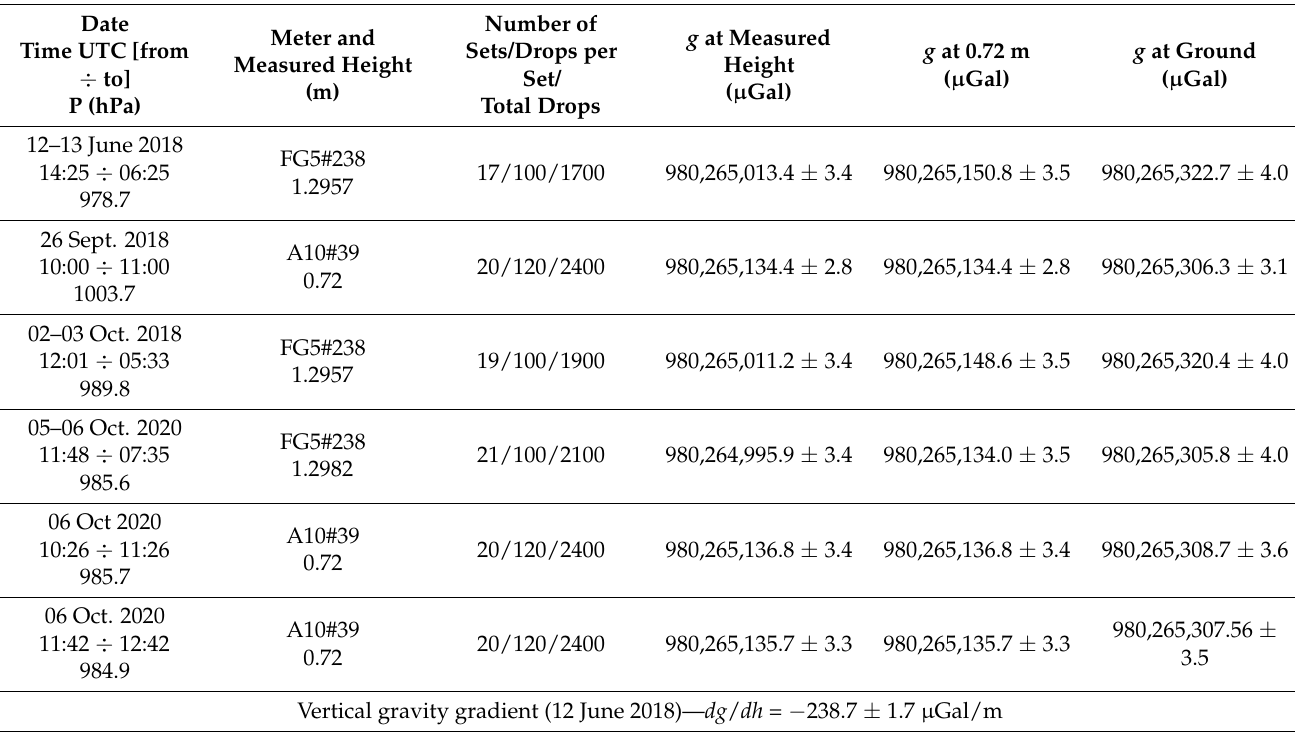
Table 5. Absolute gravity measurements collected at Popoli (POPL) station during June 2018–October 2018 and October 2020 period by FG5#238 and A10#39 absolute ballistic gravimeters. The combined uncertainties δ tot associated with the g values are also reported.